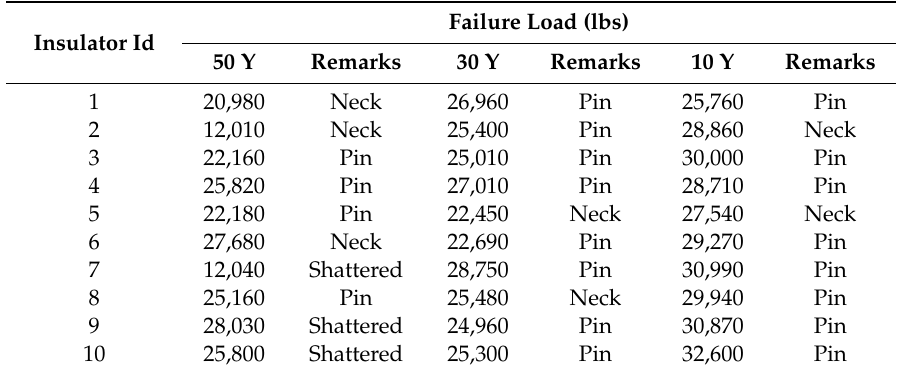
Table 2. Summary of Tensile load